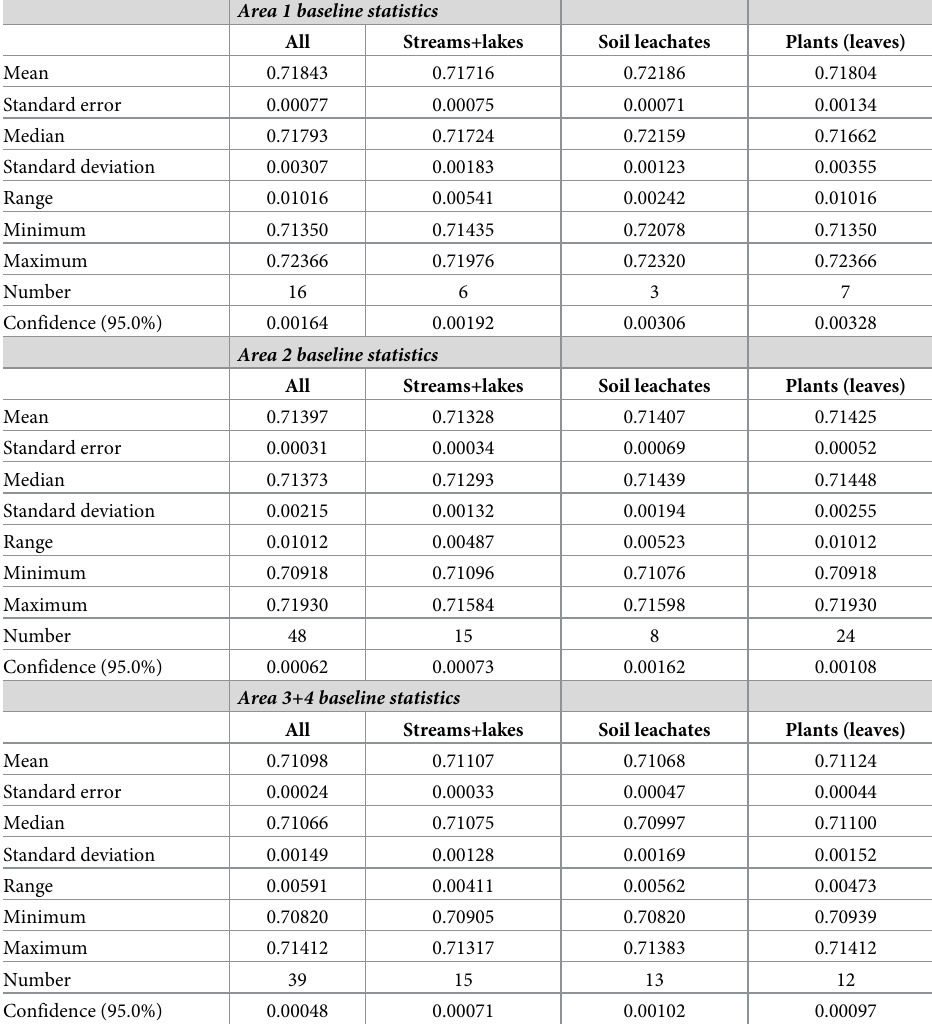
Table 4. Descriptive statistics of bioavailable 87 Sr/ 86 Sr ratios from